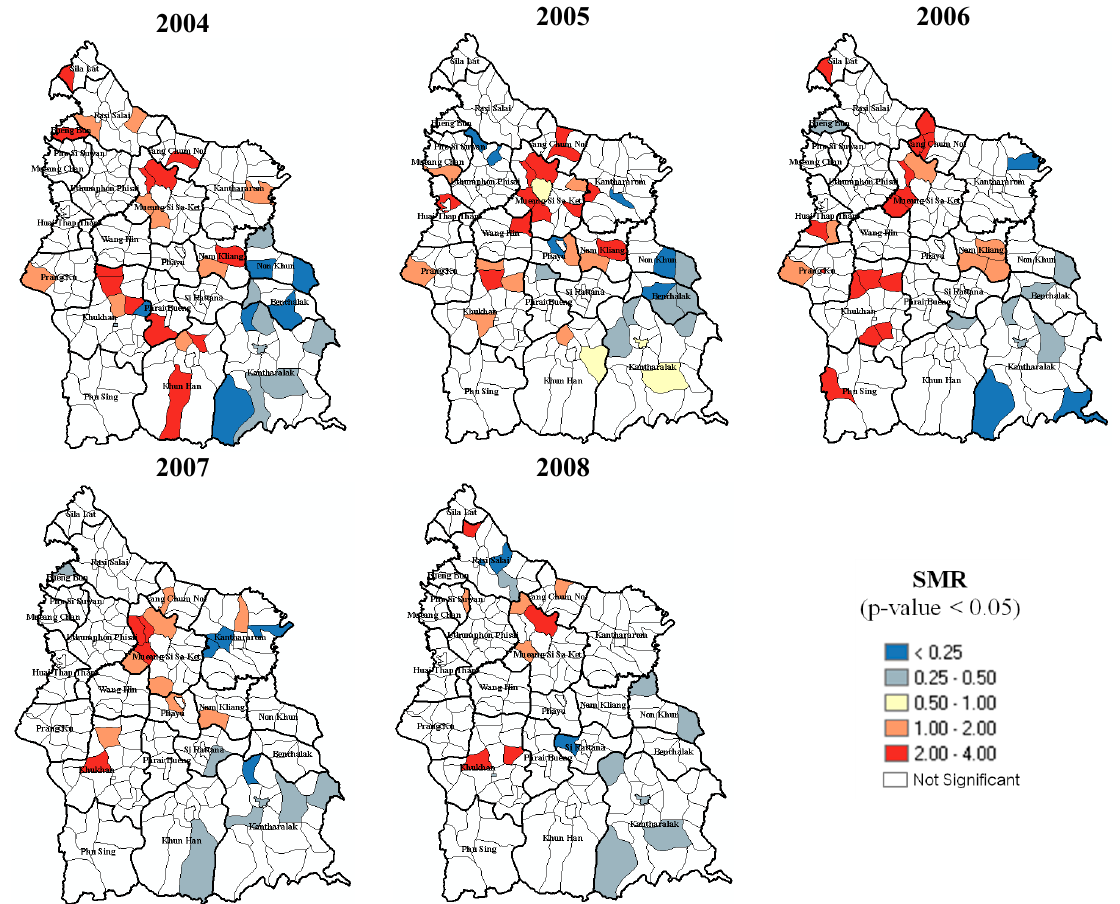
Figure 4. Standardized Morbidity Ratios (SMRs) of TB in Si Sa Ket from 2004 to 2008.